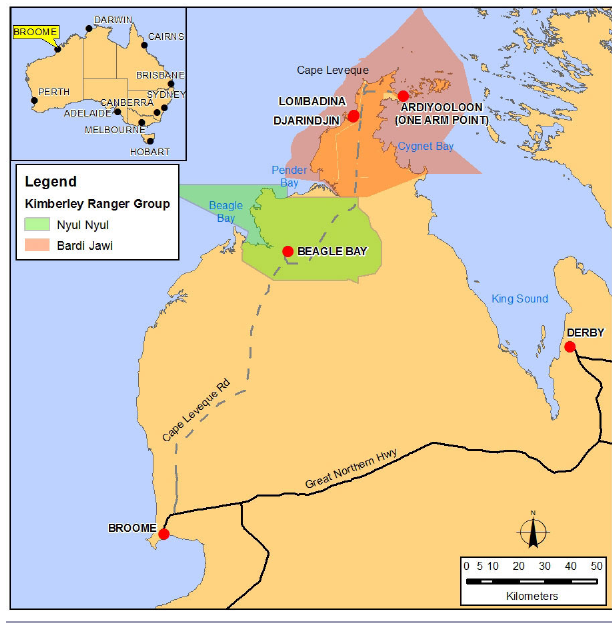
Fig. 1 . Location of the Bardi Jawi and Nyul Nyul Ranger management areas on the Dampier Peninsula north of Broome, Western